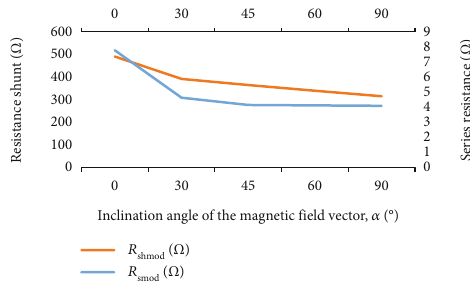
Figure 8: Series and shunt resistances against the inclination angle α of the MF vector and for an average irradiance of 630W.m -2 and B = 15